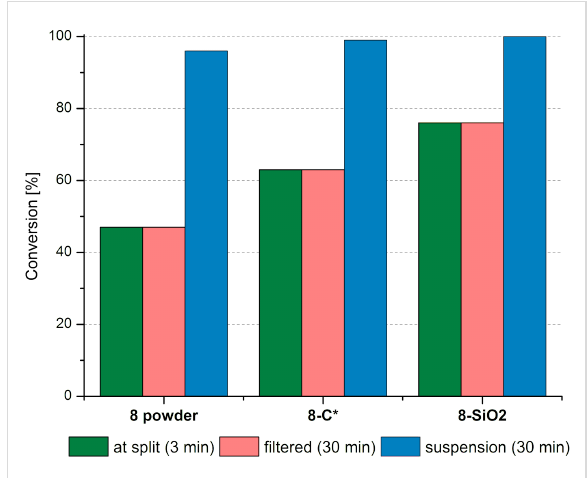
Figure 7: Split test during RCM of 9 (1 mol % cat, toluene 80 °C, [9] = 0.2 M). The reaction mixtures were filtered through a piece of cotton under argon to a flask placed in an oil bath pre-heated to 80 °C.